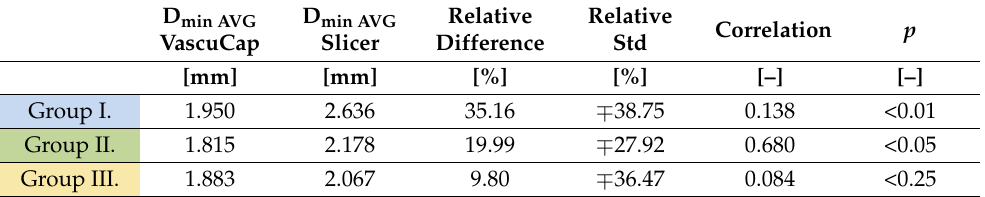
Table 3. Results of the comparison of group averaged D min values between the two segmentation methods.